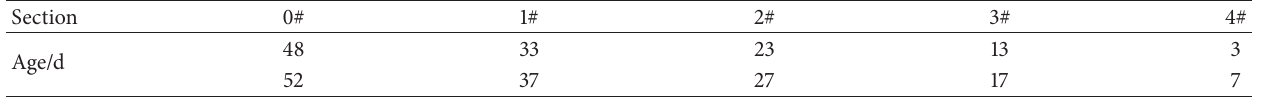
Table 3: Concrete age of each section (model I).